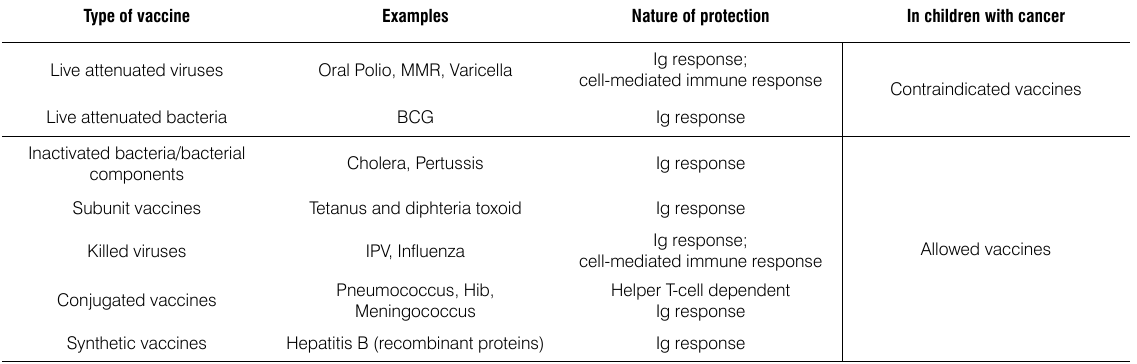
Table 1. Types of vaccines and immune response. Type of